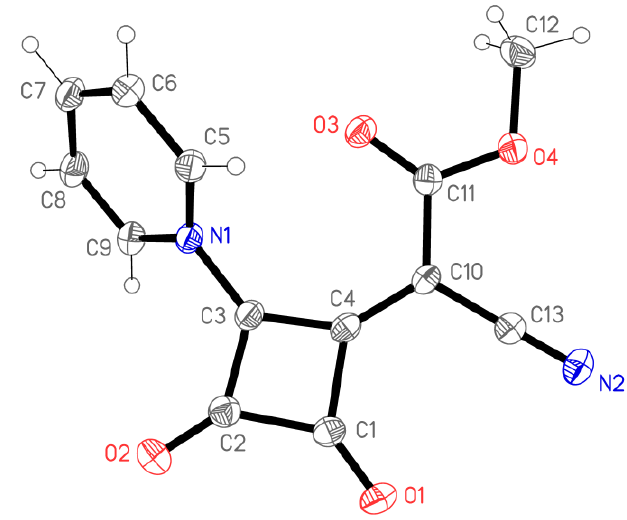
Figure 1. The molecule of compound 4 in the crystal. Ellipsoids represent 50% probability levels. Selected bond lengths (Å ) and angles (°): C1-O1 1.1999(14), C1-C4 1.5221(15), C1-C2 1.5452(16), C2-O2